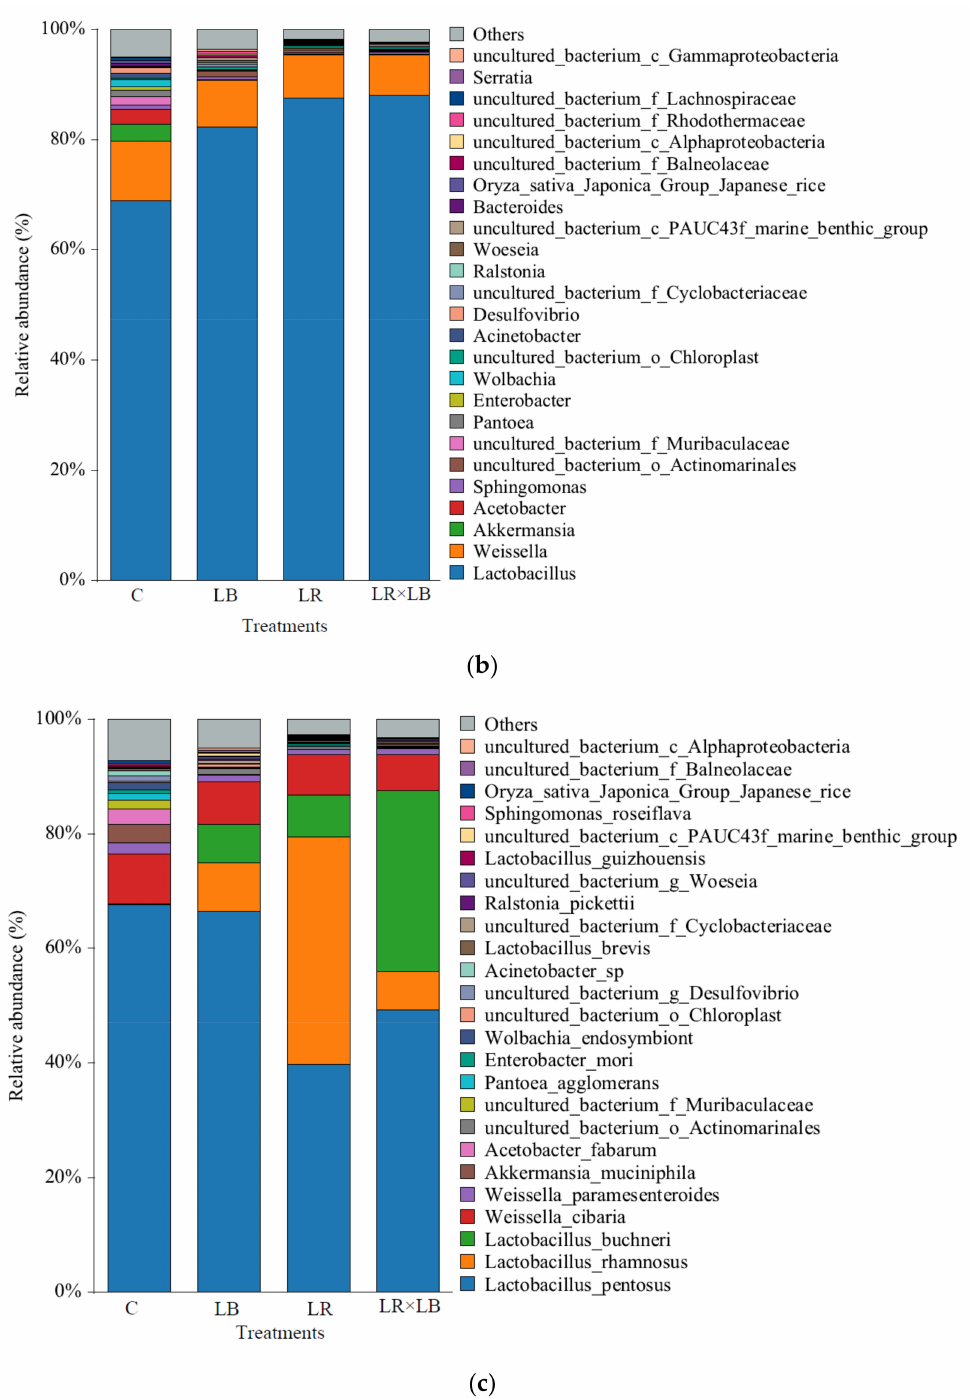
Figure 1. Relative abundances of paper mulberry silage bacterial communities. ( a ) In phylum level; ( b ) in genus level; ( c ) in species level; C: silage with distilled water; LB: silage with LB-TSy; LR: silage with LR-BDy; LR × LB: silage with LB-TSy and LR-BDy. It can be seen from Figure 2 (correlation heatmap) and Figure 3 (redundancy analysis, RDA) that the levels of L. buchneri and L. rhamnosus were positively correlated with those of LA and PA but negatively correlated with the